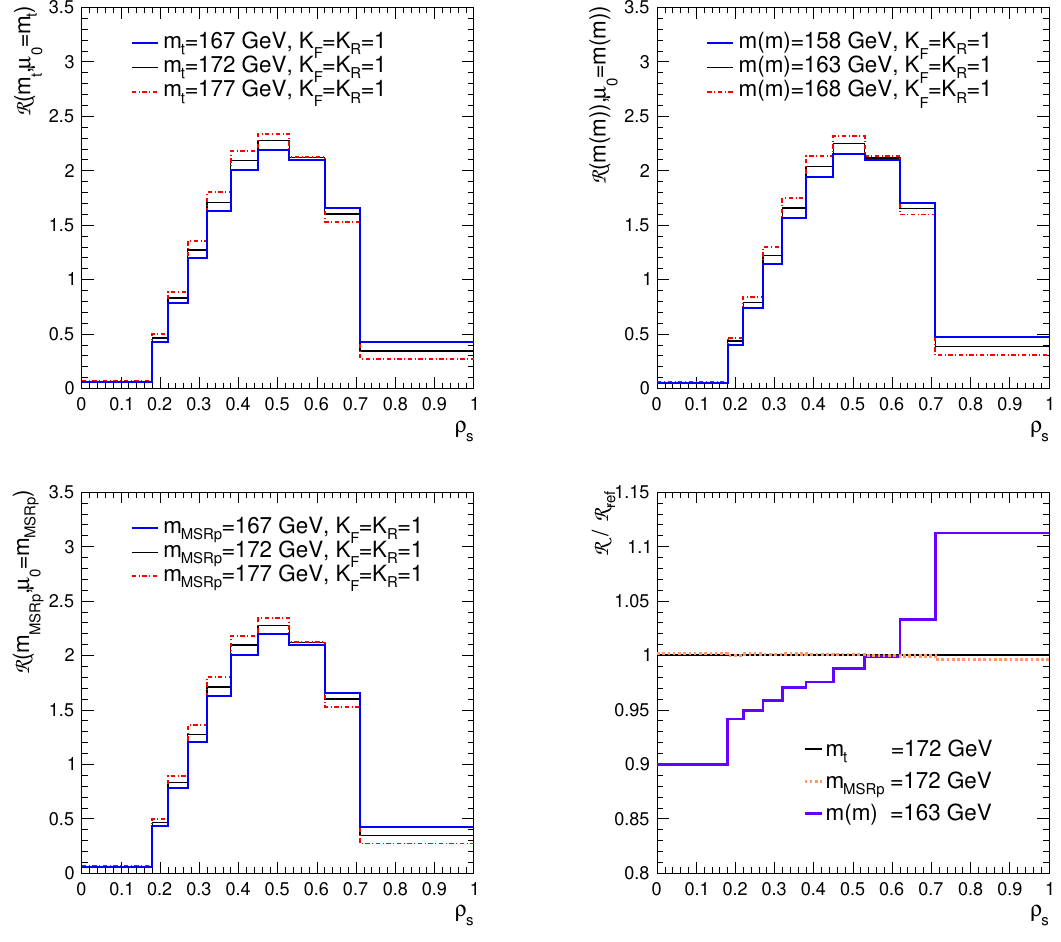
Figure 32 . R distribution using different renormalization schemes for the top-quark mass, i.e. the pole mass m t , the MS mass m ( m ) and the MSR mass m MSRp . Different lines correspond to different input masses, implying different choices for the renormalization and the factorization scales (assumed to be equal). In the last panel, ratios of predictions with the m ( m ) and m MSRp masses with respect to predictions with the on-shell mass are shown. The central CT18NLO PDF set is used as input in all